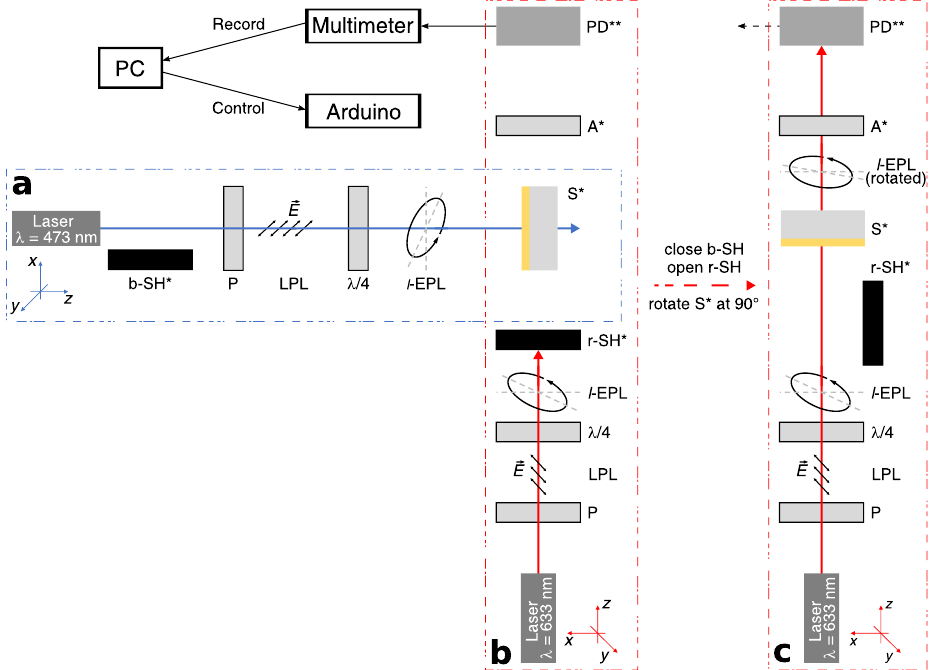
Figure 4. Experimental setup for inscribing PSC via a DPSS-laser and polarimetry via HeNe-laser: ( a ) The incident laser beam on the sample S* is ( l -EPL) by using a Polarizer P and quarter-wave plate ( λ /4). ( b ) The polarimetric setup is perpendicular to the inscription setup with the sample at the center. ( c ) Polarimetric measurements were performed with the red laser at ( l -EPL). The Photodiode PD** detects the transmitted intensity, which is displayed on a multimeter. Components marked with * are connected to a microcontroller (Arduino). The mark ** means a connection to the multimeter. b-SH*: shutter for blue laser, P: Polarizer, LPL: linear polarized light, λ /4: quarter-wave plate, l -EPL: left-handed elliptically polarized light, S*: Sample, r-SH*: shutter for red laser, A*: Analyzer, PD**: Photodiode, (cid:126) E : electric-field